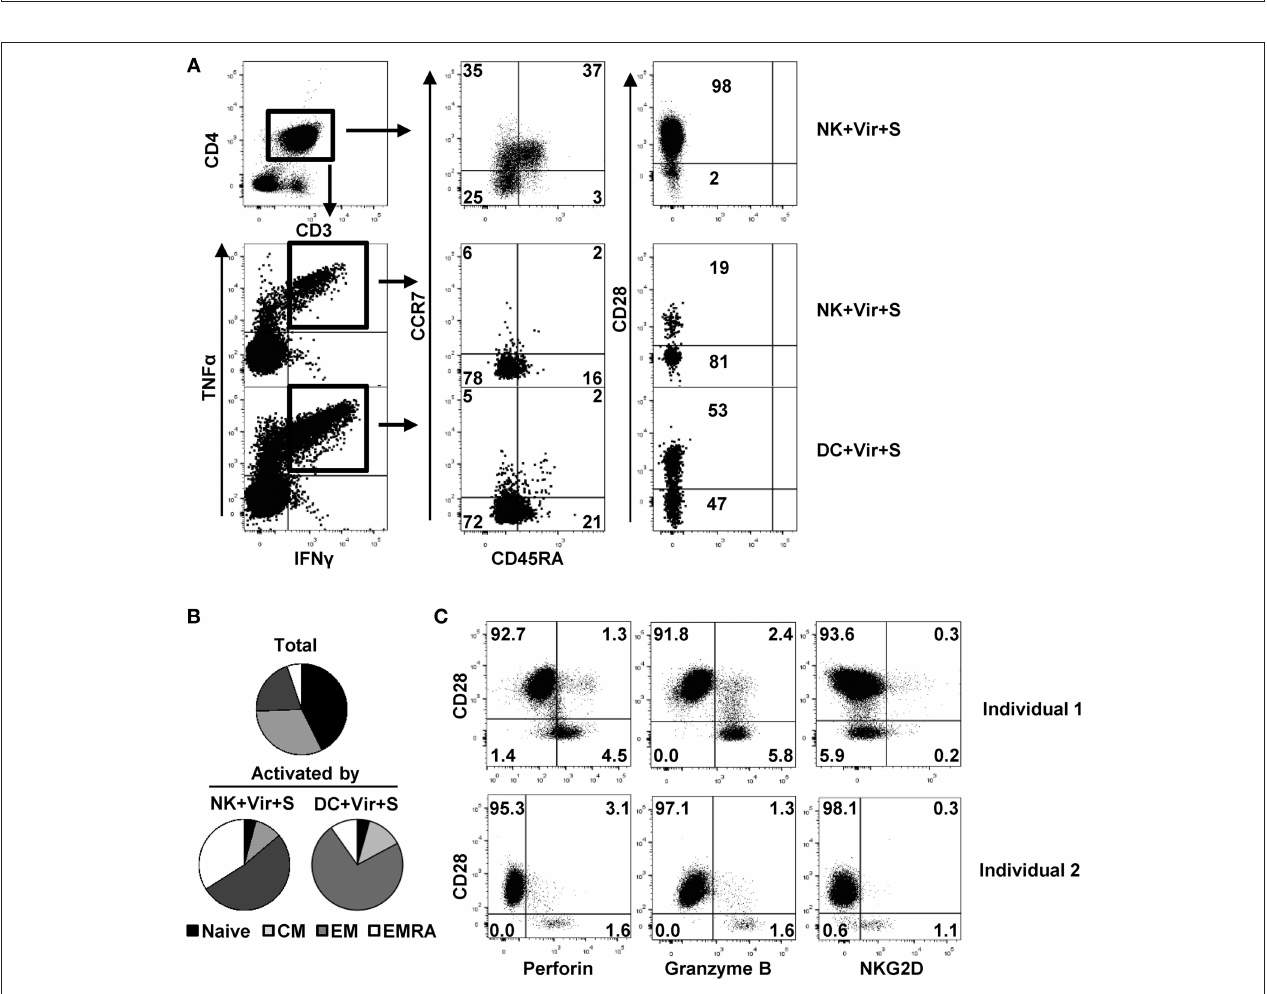
FIGURE 5 | Differentiation and functional profile of HCMV-specific CD4 + T cells activated by antigen-presenting NK cells. NK cells or moDC previously loaded with HCMV in the presence of specific antibodies were cultured with autologous CD4 + T cells and the production of TNF α and IFN γ in combination with CD45RA, CCR7, and CD28 differentiation markers was analyzed by multiparametric flow cytometry. (A) Dot plots showing CD45RA, CCR7, and CD28 expression in total and activated (IFN γ + TNF α + ) CD4 + T cells from a representative donor out of four in the indicated conditions. (B) Pie chart showing the distribution of CD4 + T cell subpopulations based on CCR7 and CD45RA at baseline and of those T cells activated by antigen-presenting NK cells and DC ( n = 4). (C) Perforin, granzyme B, and NKG2D expression in CD28 + and CD28– CD4 + T cells from two representative HCMV + individuals out of three